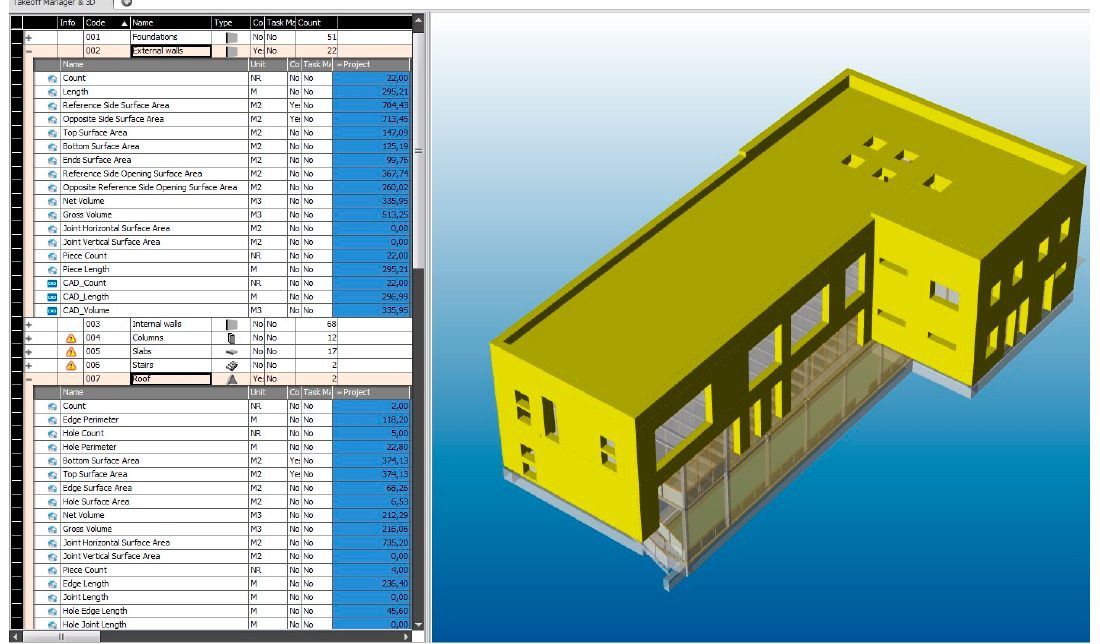
ff quantities in VO